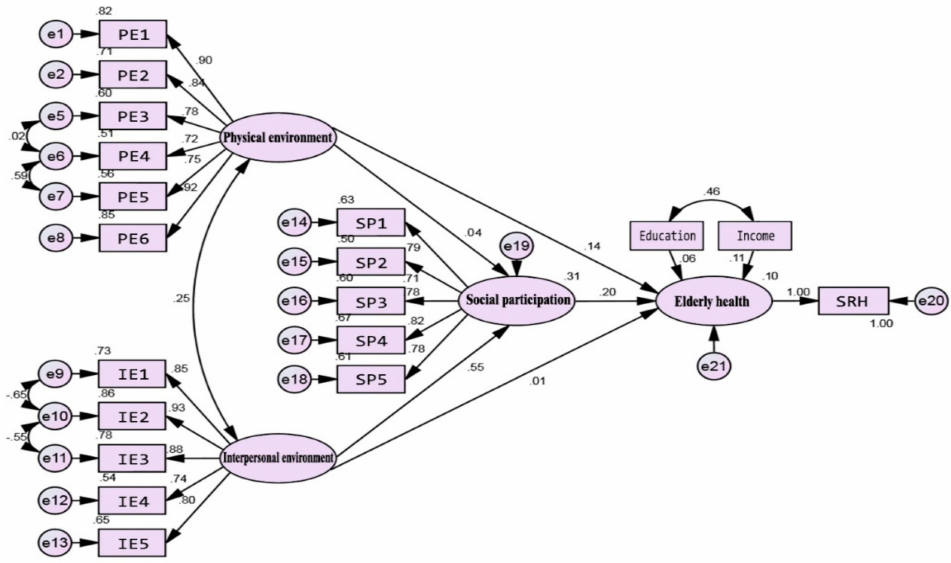
Figure 4. Standardization coe ffi cients for full sample